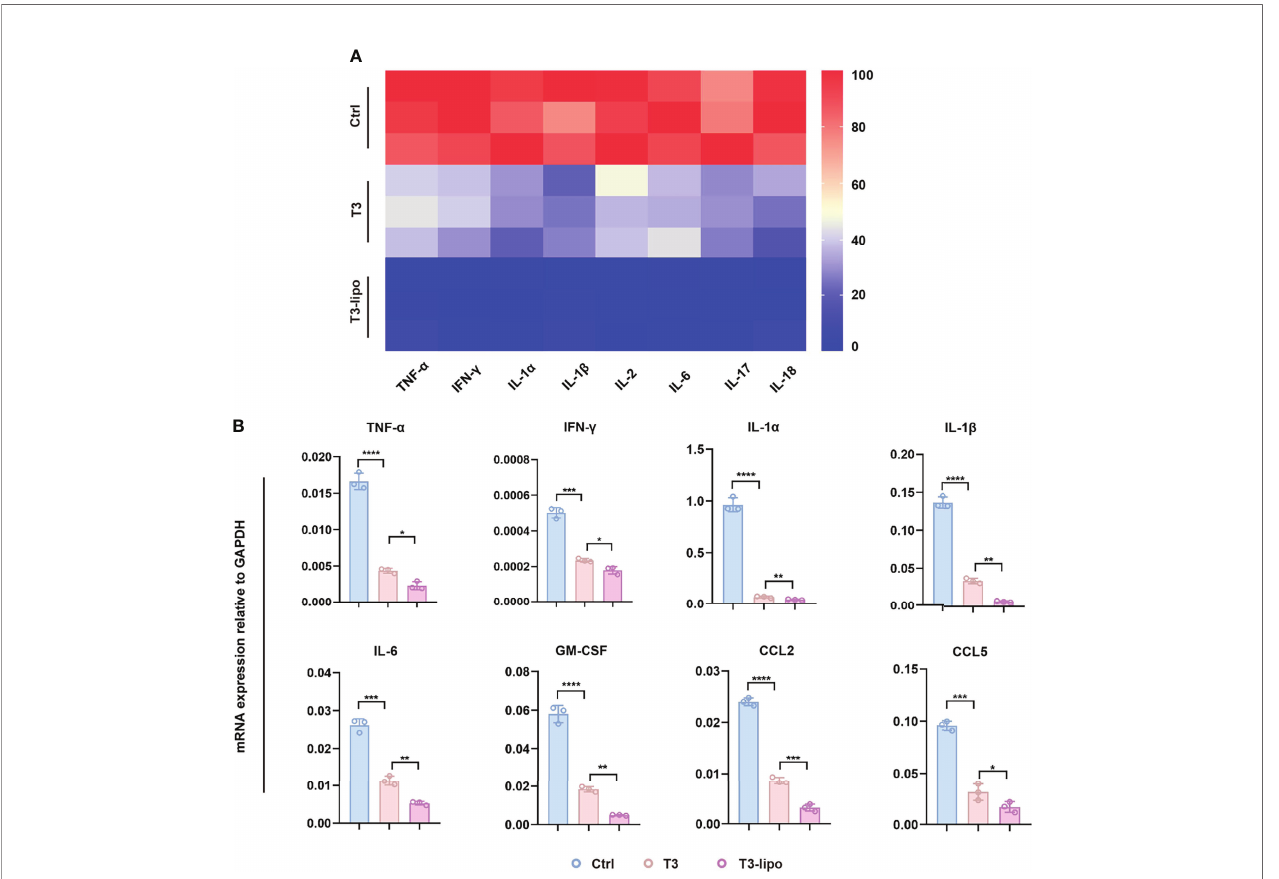
FIGURE 3 | T3-lipo attenuates liver in fl ammation in DEN-induced primary HCC rat models. (A) Bio-Plex assays of in fl ammatory cytokines (TNF- a , IFN- g , IL-1 a , IL- 1 b , IL-2, IL-6, IL-17, and IL-18) in serum. (B) RT-PCR analysis of TNF- a , IFN- g , IL-1 a , IL-1 b , IL-6, GM-CSF, CCL2, and CCL5 mRNA in livers treated with saline, T3, or T3-lipo in DEN-induced rat models. Mean ± SD values were obtained from at least three independent experiments performed in triplicate. Differences were analyzed using One-way ANOVA (*p < 0.05, **p < 0.01, ***p < 0.001, and ****p <